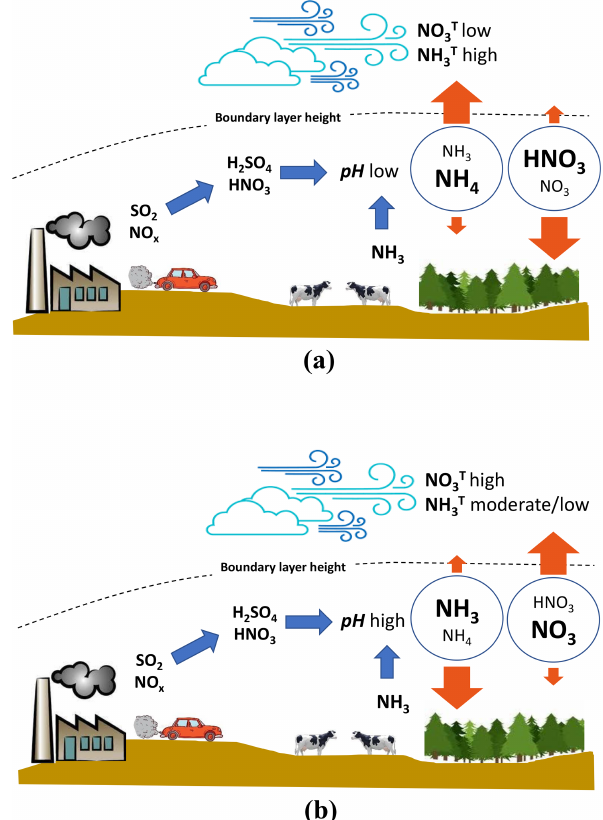
Figure 5. Summary sketch of the interactions between aerosol pH and emissions of total ammonium and nitrate. (a) Aerosol pH is low and LWC is moderate, as is characteristic of the SE United